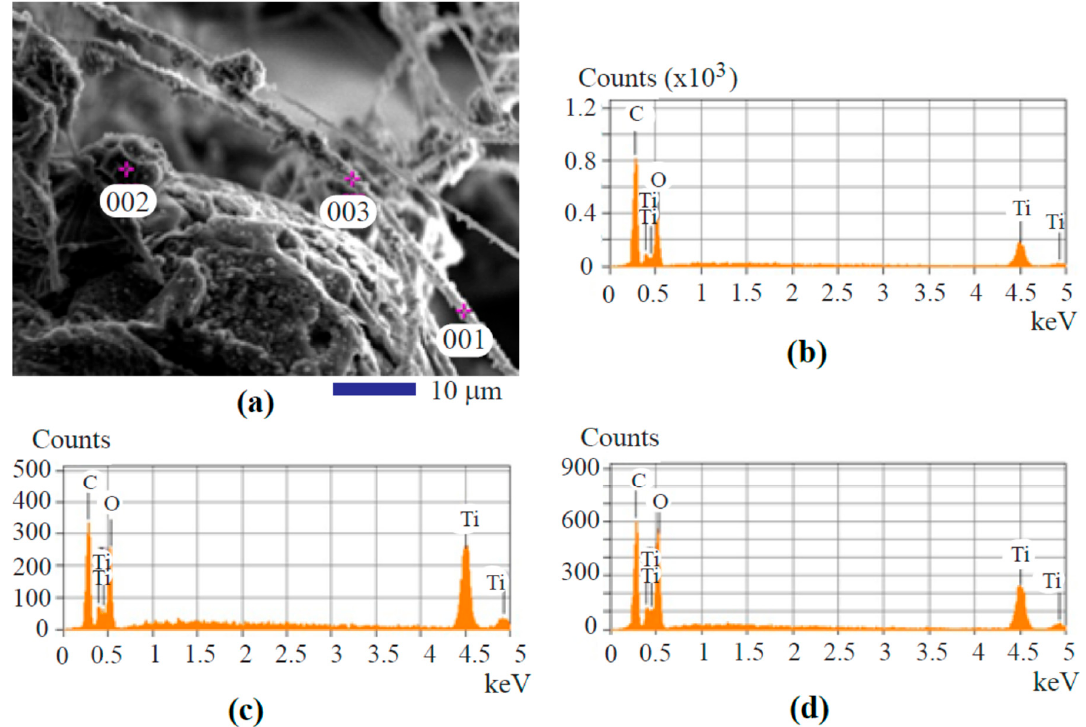
Figure 5. The specific location selections for the spot analysis and the element analysis results: (a) SEM image showing the locations for Energy Dispersive Spectrum (EDS) spot analysis; (b) the energy dispersive spectrum of location 001; (c) the energy dispersive spectrum of location 002; (d) the energy dispersive spectrum of location 003.